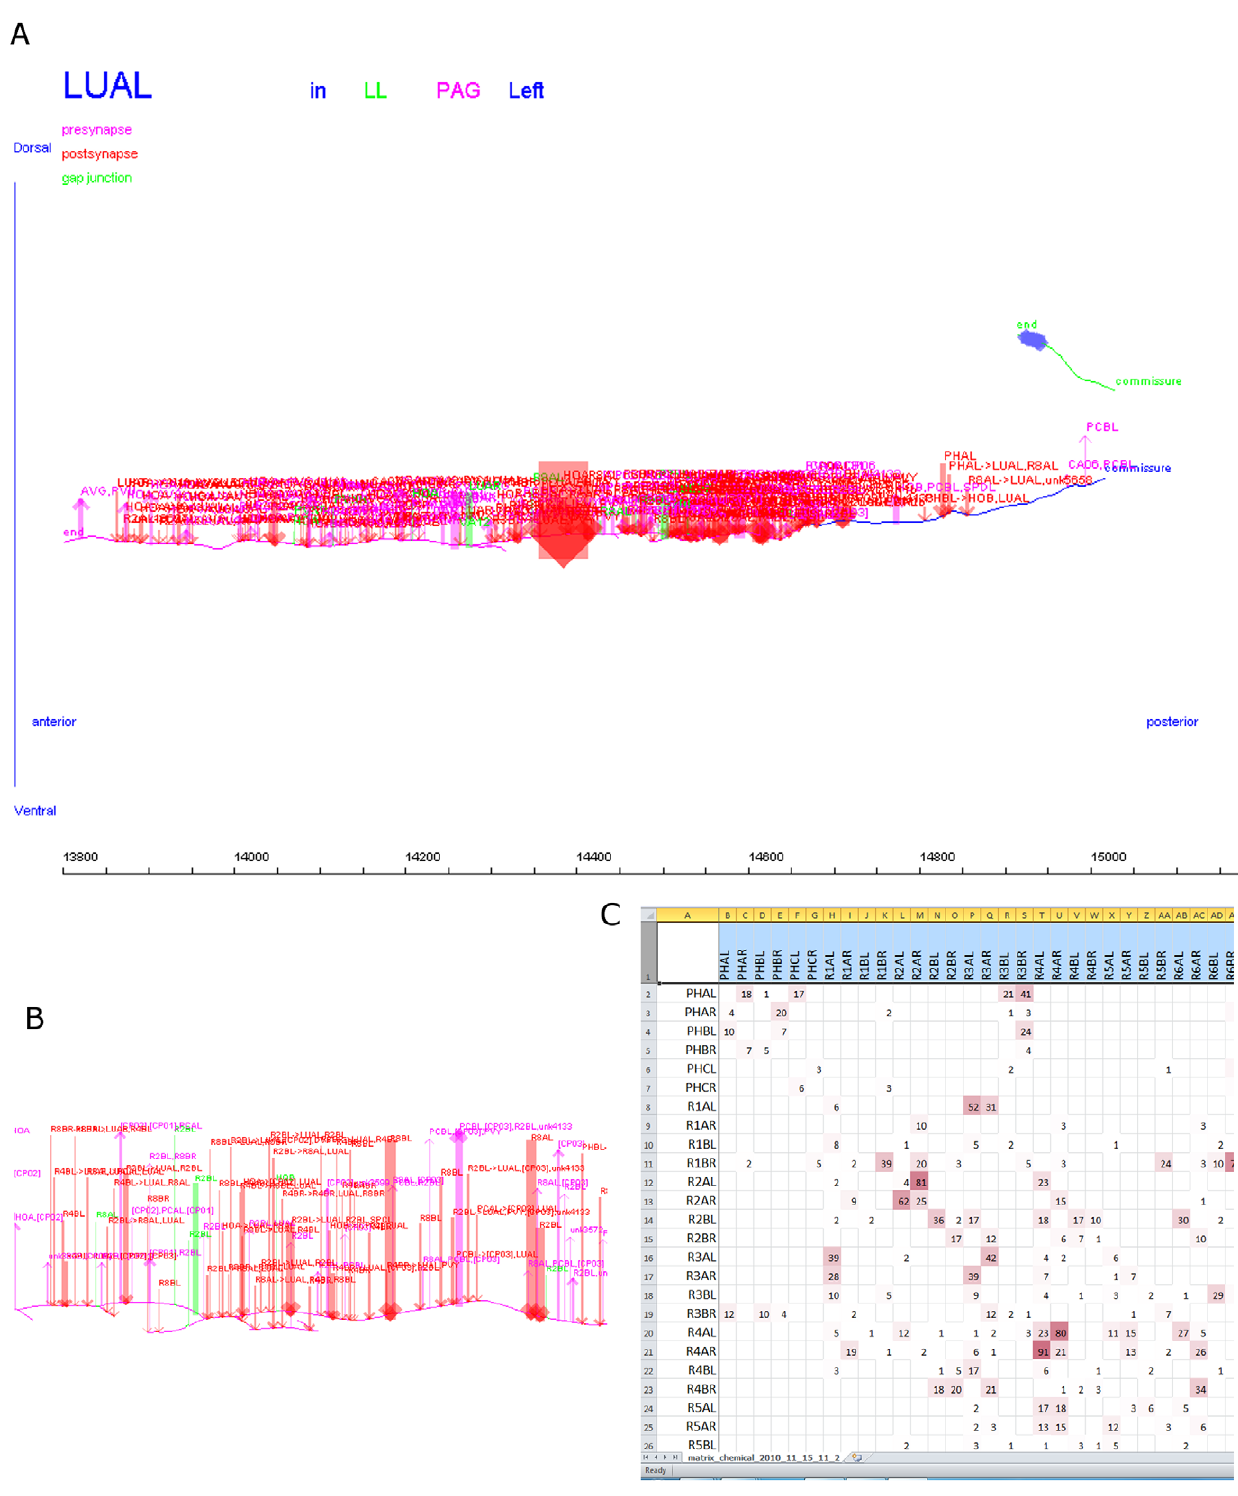
Figure 2. Elegance output. A. 2D map of the C. elegans neuron LUAL in the adult male [9]. The scale indicates section number (70–90 nm section thickness). The cell body (solid blue box) is in the left lumbar ganglion and is connected through a commissure to a process in the pre-anal ganglion which is dense with synapses. B. Enlargement of a small region of the LUAL map, showing branching architecture and locations of synapses; line thickness indicates synapse size (red: chemical input, magenta: chemical output, green: gap junctions). C. Portion of the adjacency matrix of chemical connectivity in the C. elegans male posterior nervous system [9], generated by Elegance and formatted in Excel. Pre-synaptic neurons to left, post- synaptic neurons at top, connection strength in number of serial sections.